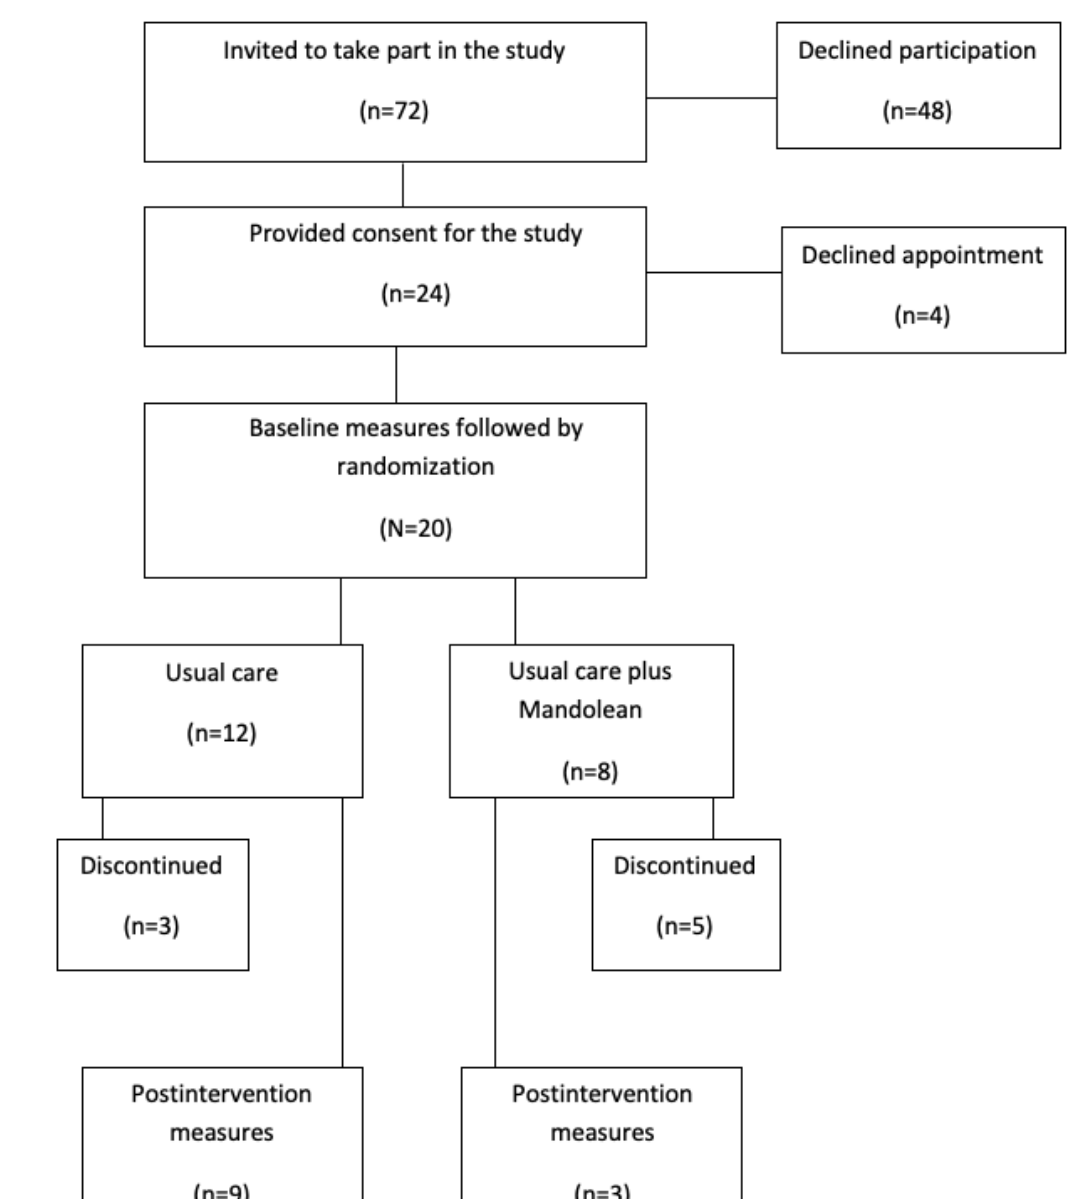
Figure 2. Consolidated standards of reporting trials diagram for pilot randomized